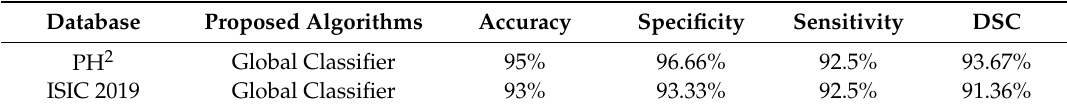
Table 5. Experimental results for the global